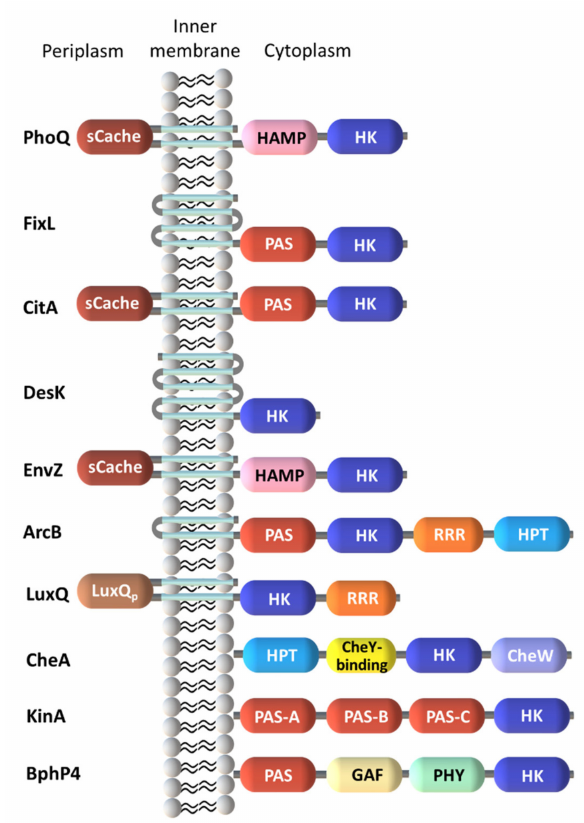
Figure 3. Sensor kinase domain architecture obtained from the available structural information combined with the SMART annotation (adapted from [30]). Abbreviations: sCache—single calcium channels and chemotaxis receptor; PAS—period clock protein, aryl hydrocarbon receptor and single- minded protein; HAMP—domain found in histidine kinases, adenylyl cyclases, methyl-binding proteins and phosphatases; RRR—response regulator receiver domain; HPT—histidine containing phosphotransfer; GAF domain—non-catalytic cGMP phosphodiesterase/adenylyl cyclase/FhlA- binding domain;